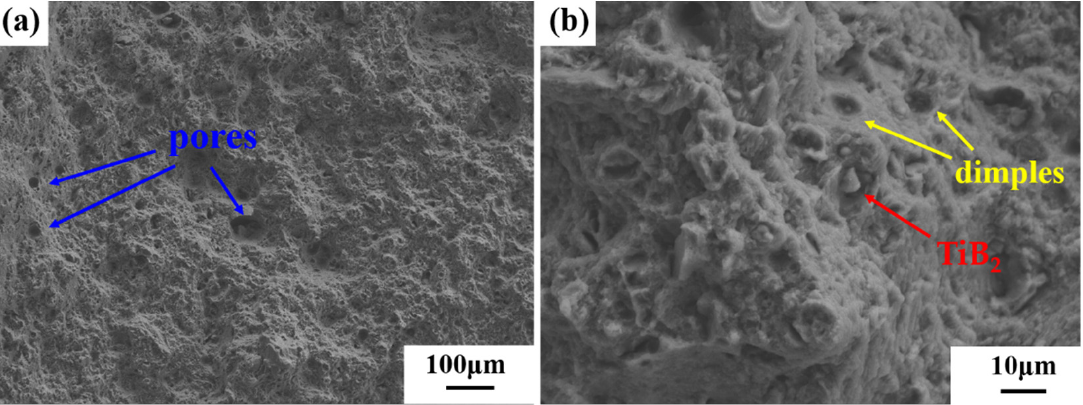
Figure 13. Fracture surfaces of SLM-fabricated TiB 2 /AlZnMgCu(Sc,Zr) composite as-printed sample ( a ) in relatively low magnification and ( b ) in relatively high magnification show dimples.